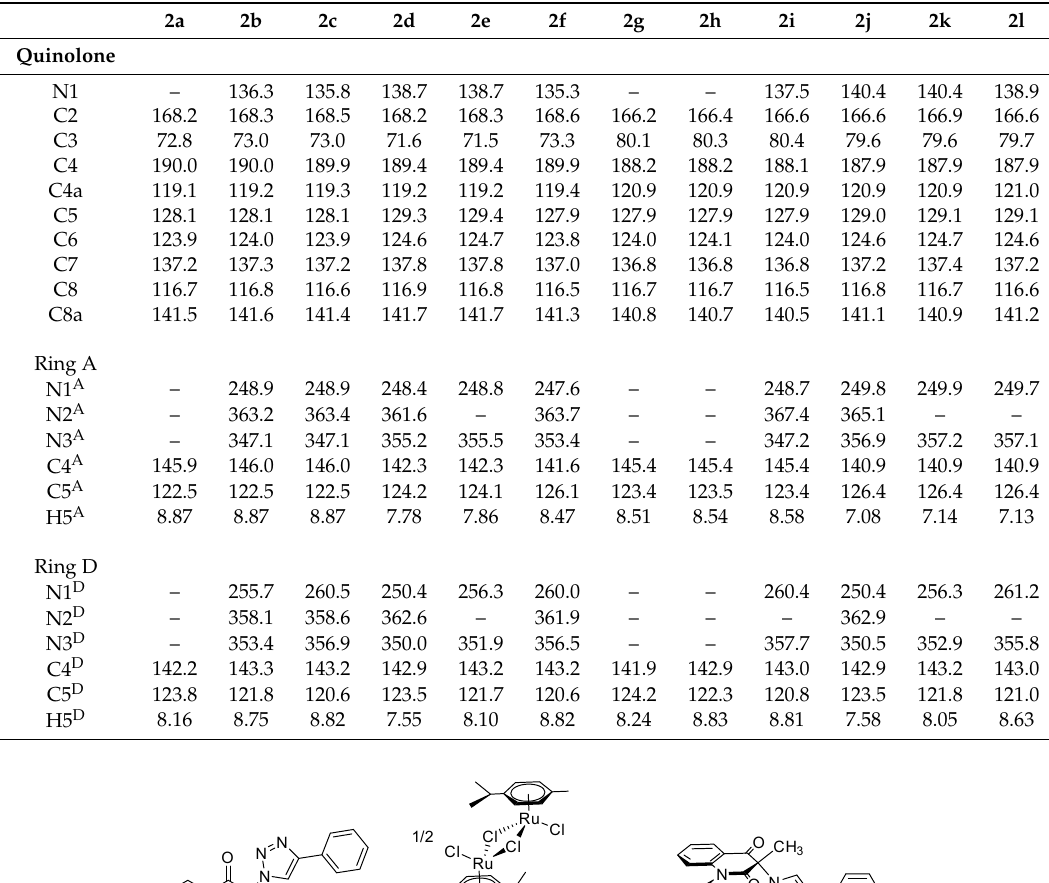
Table 6. Selected 1 H, 13 C and 15 N NMR chemical shifts in ppm for compounds 2 .